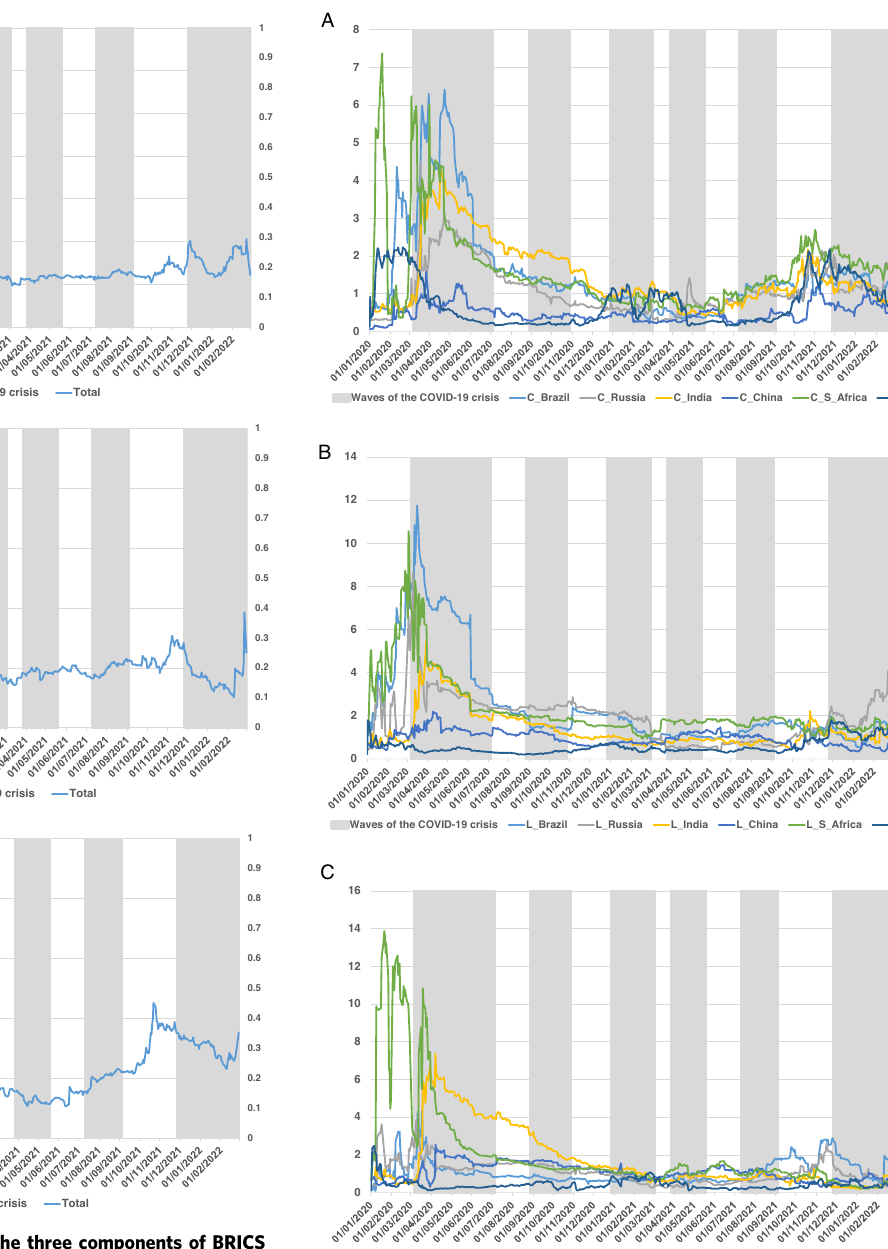
Fig. 2 Dynamic contribution TO the system of the three components of BRICS term structure. Figure plots the time-varying connectedness TO measure between the BRICS term structure of interest rates (decomposing into level ( A ), slope ( B ), and curvature ( C )) using the TVP-VAR framework (Antonakakis and Gabauer, 2017), during the waves of the COVID-19 pandemic